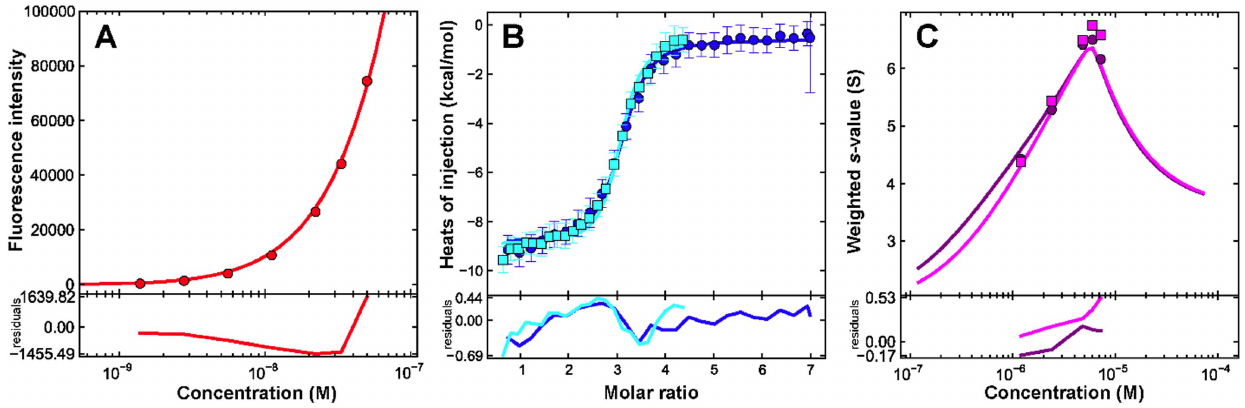
Figure 5. The interaction of the Fab 8062 with (CCIZN36) 3 . Solid lines show the global best-fit to a non-cooperative A + B + B + B interaction in which the trimer A has three symmetric binding sites. A global analysis of the data returns a K d1 affinity of 4.2 nM. (A) Binding affinity of 8062 for the 3-H. Corrected fluorescence intensity differences (325–355 nm) as a function of the complex concentration in a dilution experiment using a Fab 8062/ 3-H complex previously characterized by sedimentation velocity (Fig. X1B). (B) Binding enthalpy of 8062 for the 3-H. Isothermal titration calorimetry data for the titration of 18 m M 8062 into a solution containing 0.67 m M (blue) or 1.00 m M (cyan) trimer. (C) Interference s w isotherm (magenta) and absorbance s w (purple) isotherm (Fig. 2B) data along with the best-fits obtained in a global analysis of the data sets shown.